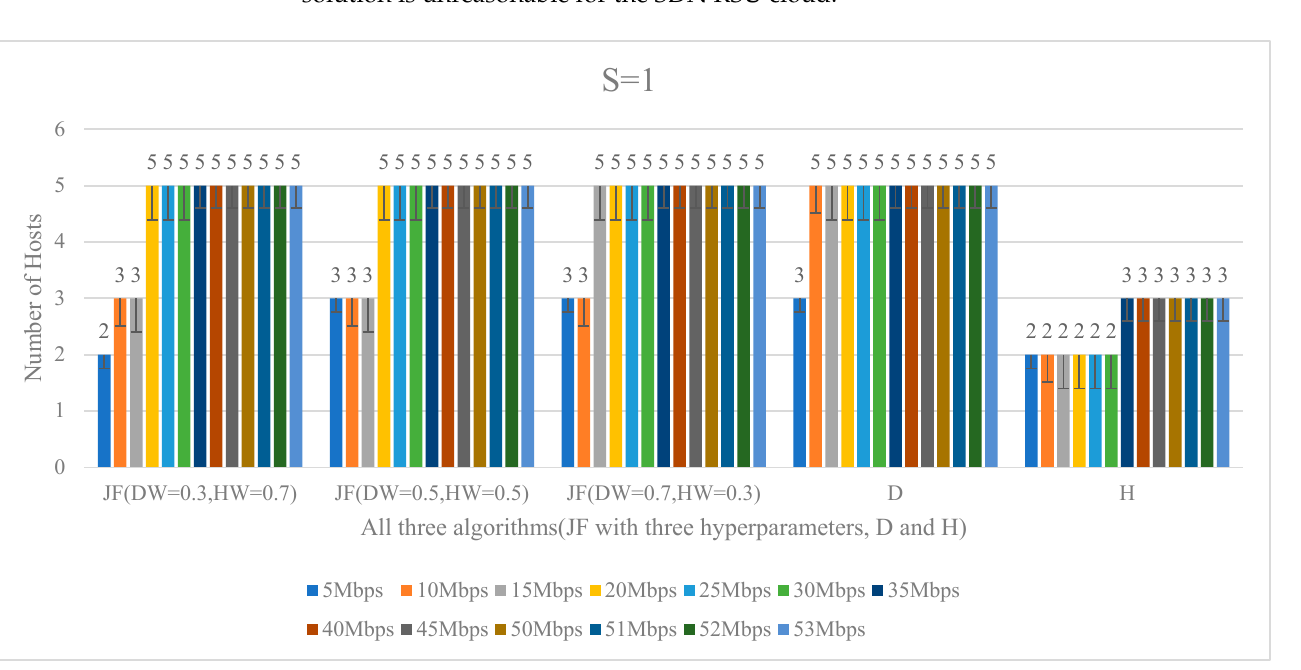
Figure 6. Hosts number under various communication demands for all three algorithms (JF with three different hyperparameters, D and H).